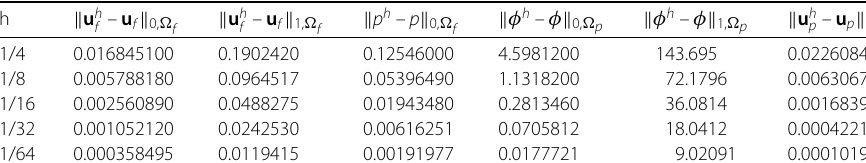
Table 4 Approximate error of the stabilized finite element scheme for test 2 with K = 0.001 I